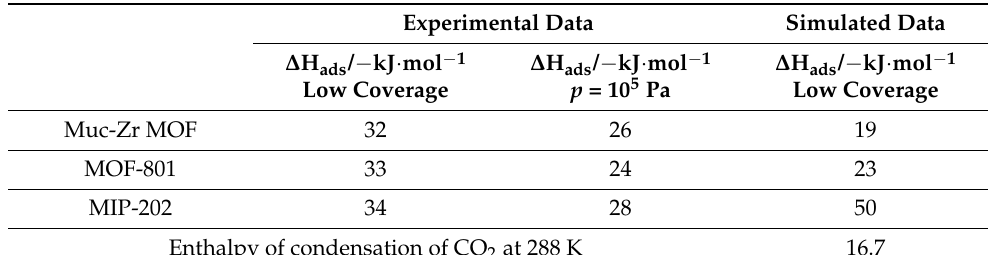
Table 3. Enthalpies of adsorption of CO 2 by the three